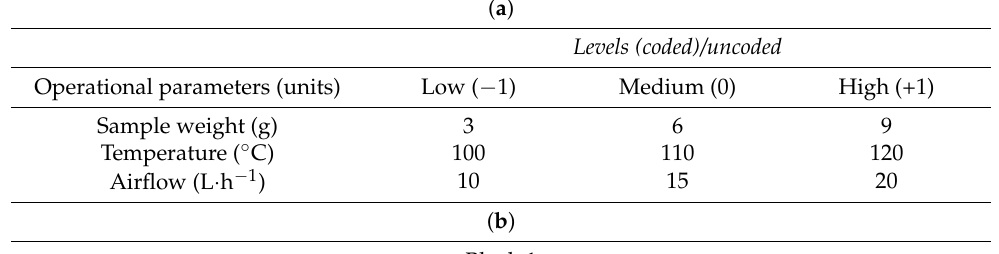
( a ) Levels (coded)/uncoded